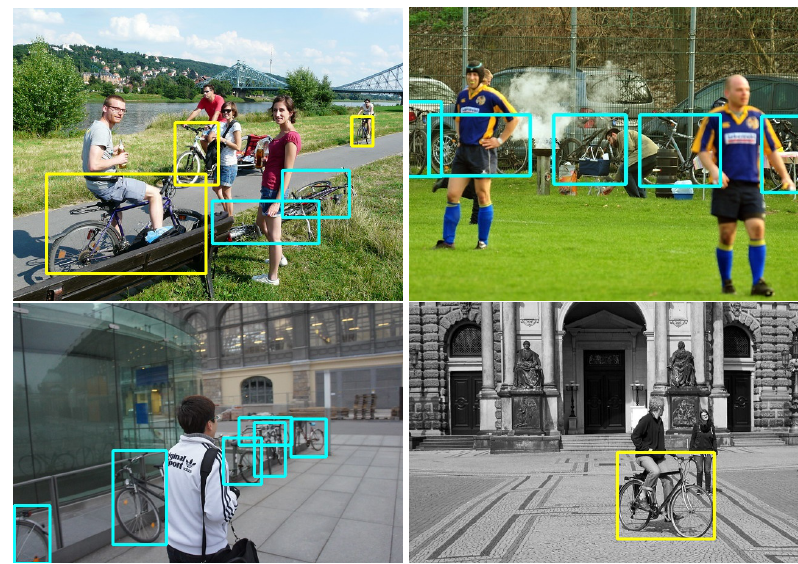
Figure 2. Examples from our annotated Dresden subset of the YFCC100m dataset. We manually labeled both moving (yellow boxes) and stationary (cyan boxes)